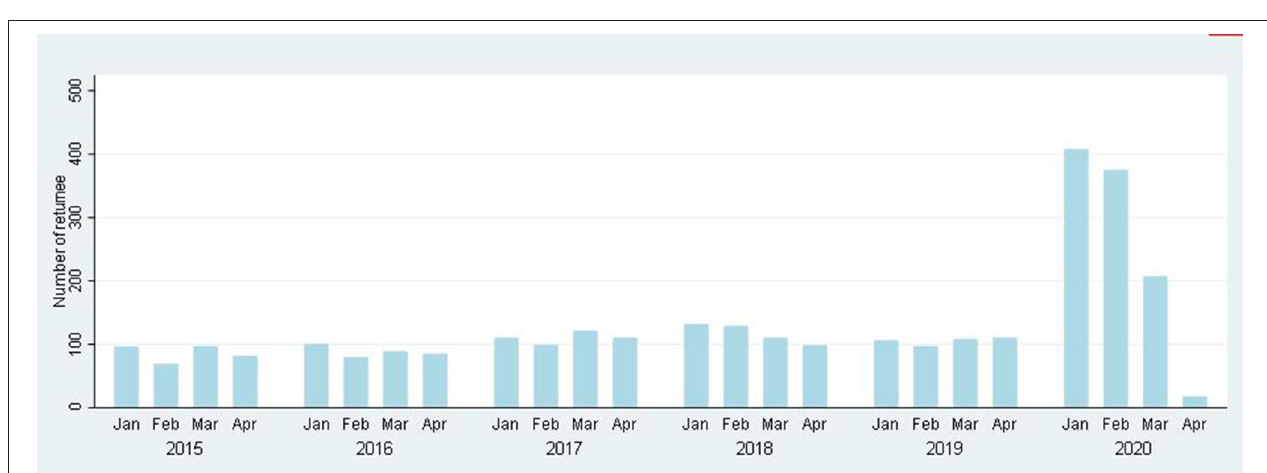
FIGURE 2 | Number of people returned from abroad between 2015 and 2020.